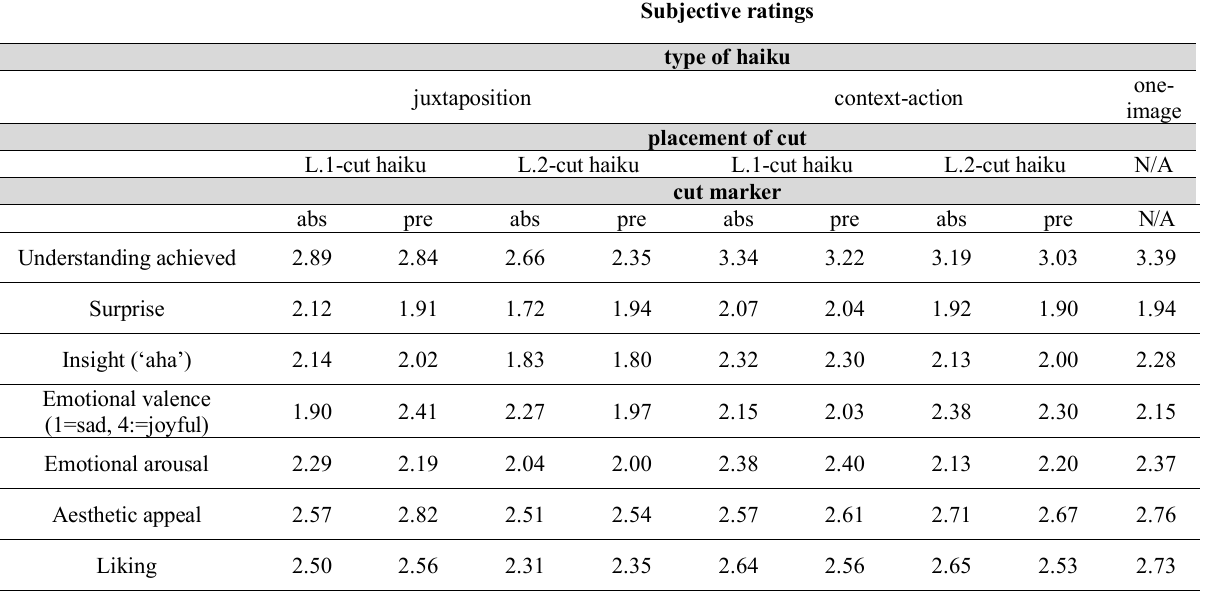
Table 4 . Mean subjective ratings on all seven rating scales (understanding achieved, feelings of surprise, ‘aha’ experience, joyful vs. sad emotional valence, emotional arousal, aesthetic appeal, and liking) as a function of our (haiku type, placement of cut, cut marker) experimental manipulations. The right column shows the ratings obtained for one-image (control)